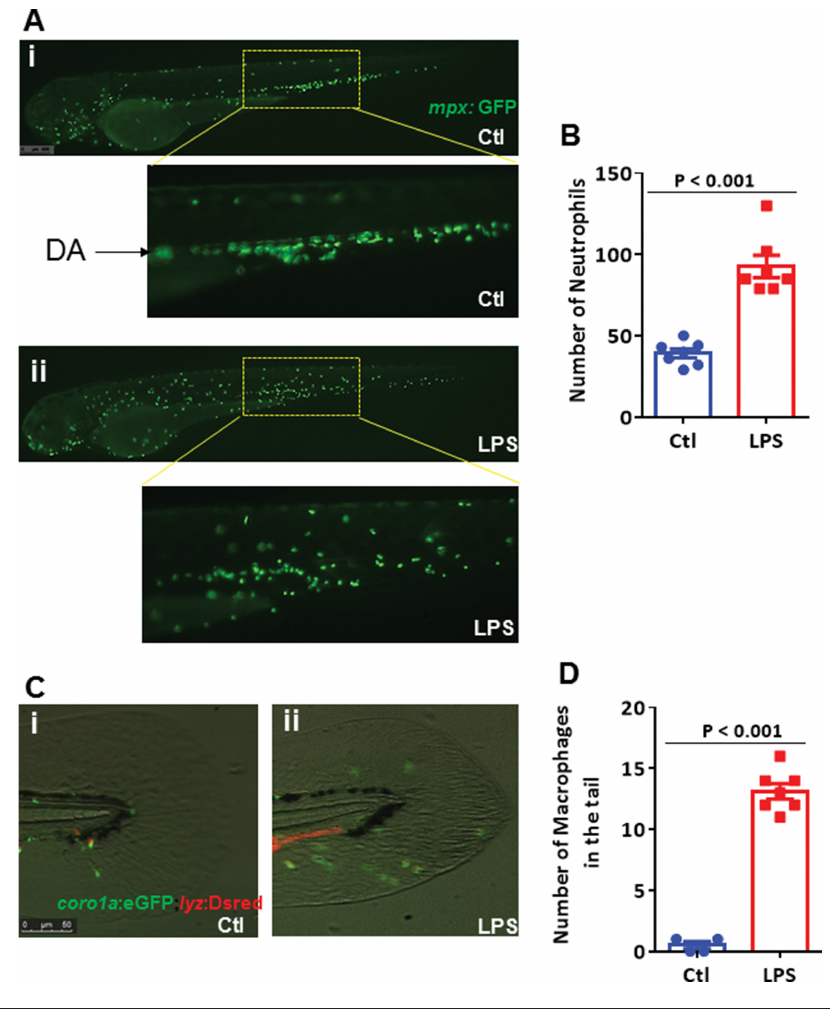
Figure 4. Immune cell migration in endotoxemic zebrafish. (A, B) LPS exposure in mpx: GFP larvae causes extravascular migration of neutrophils from major blood vessels, namely the dorsal aorta (n = 7/treatment). (C, D) LPS exposure in coro1a :eGFP; lyz :Dsred also in- duces migration of macrophages out of the intravascular space into extravascular fluid in edematous tails (n = 7/treatment). DA: dorsal